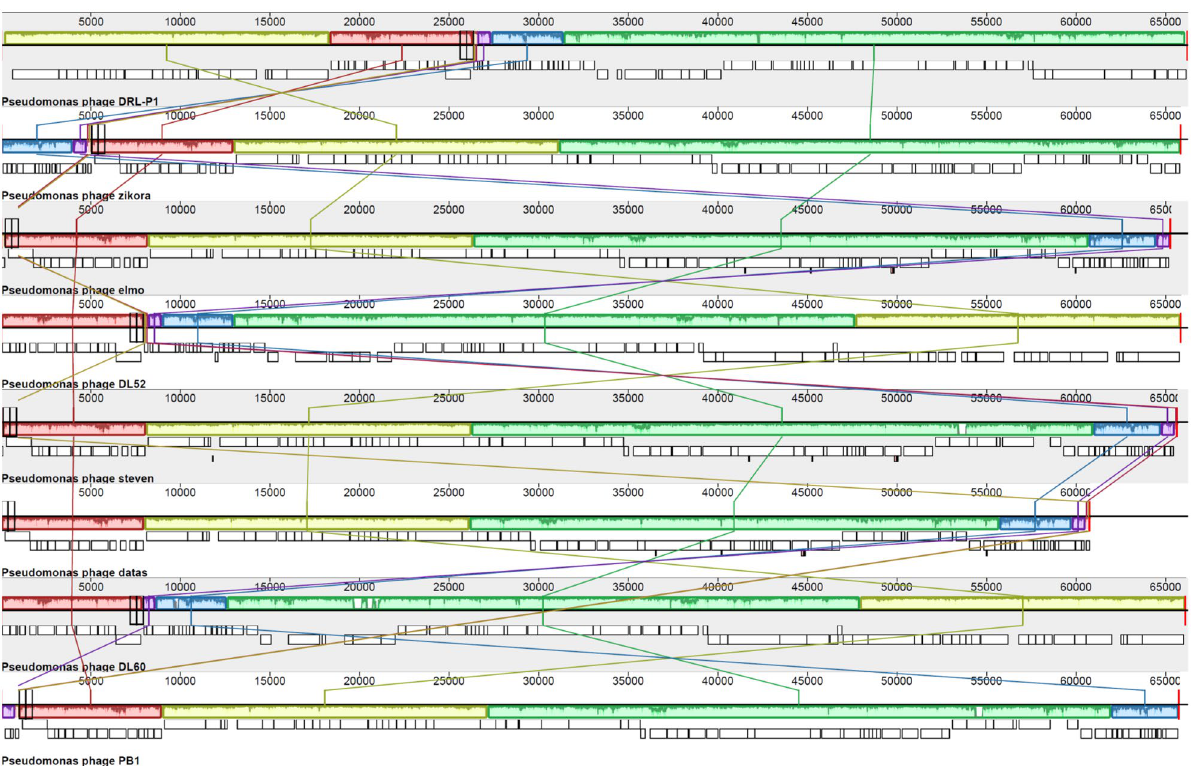
Figure 7. Results of Mauve progressive alignment of annotated complete genome sequences of DRL-P1 with related Pbunaviruses ‘zikora’, ‘elmo’, ‘DL52’, ‘steven’, ‘datas’, ‘DL60’ and ‘PB1’ (from top to bottom). Relative position of the homologous regions or the locally collinear blocks (LCBs) shared by two or more genomes are depicted by same colors. Similarity of the LCBs between genomes are signified by plot within the blocks, where the height of the plot represents mean nucleotide identity. Relative position of the homologous LCBs among the genomes are indicated by thin vertical lines of same-color. The white blocks under the LCBs represent genome features (annotated ORFs) obtained from the GenBank. Graphical presentation of the alignment of LCBs was generated using the progressiveMauve computer program version 2.4.0 (http:// darli nglab. org/ mauve/ mauve.